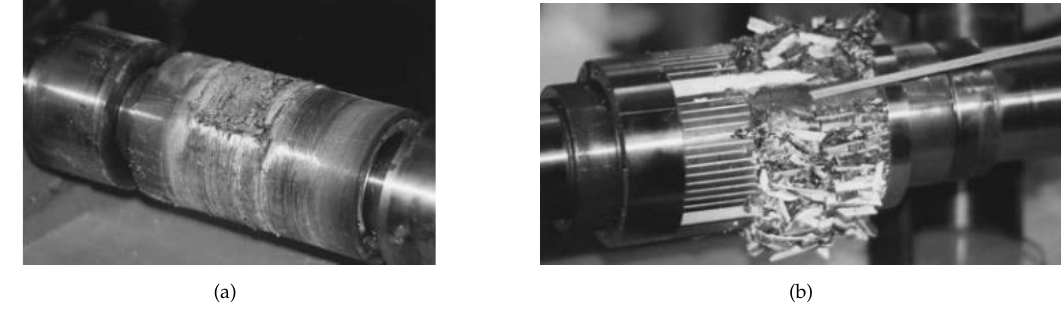
Figure 19. Destruction of brittle magnets underneath the broken bandage [110].